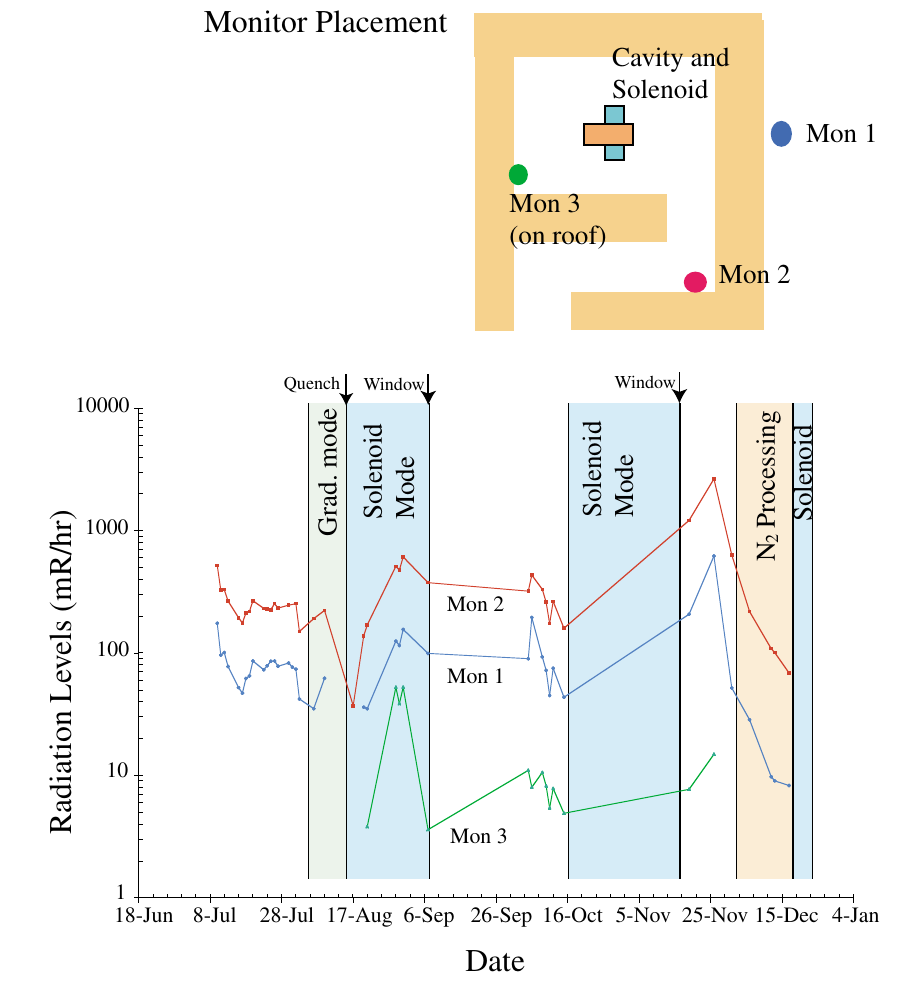
FIG. 21. (Color) The radiation history of the facility during rf processing with and without solenoidal